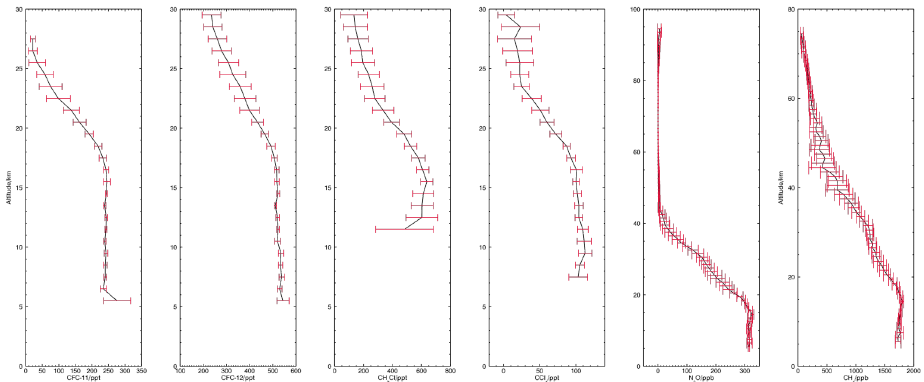
Figure C8 The mean vertical profile of CFC-11, CFC-12, CH3Cl, CH4 & N2O, calculated using data from 2009 between 15° and 30° South Fig. C9. The mean vertical profile of CFC-11, CFC-12, CH 3 Cl, CCl 4 , N 2 O and CH 4 , calculated using data from 2009 between 15 ◦ and 30 ◦ S.